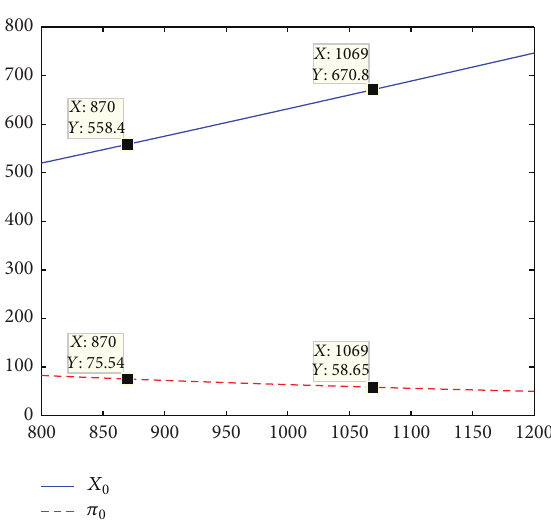
Figure 2: The influence of riskless interest rate.